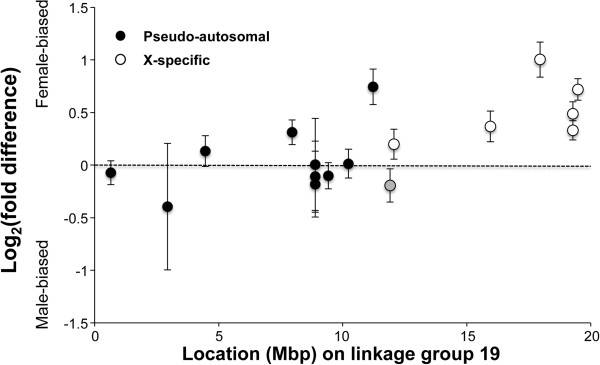
Female-biased expression of miRNA expressed from the non-recombining region of the X chromosome (linkage group 19). Black circles indicate small RNAs on the pseudoautosomal region, whereas white circles indicate small RNAs from the X-specific region. A small RNA, for which it was not clear whether the RNA was located on the pseudoautosomal or X-specific region, is indicated by a grey circle. For statistical analysis, the grey circle was excluded. Data from the Japan Sea and Pacific Ocean fish were pooled. Because the order of the LG19 sequence assembly on the ensembl is inverted after 3.822 Mbp, physical locations on LG19 followed [62]. Error bars indicate S.E.